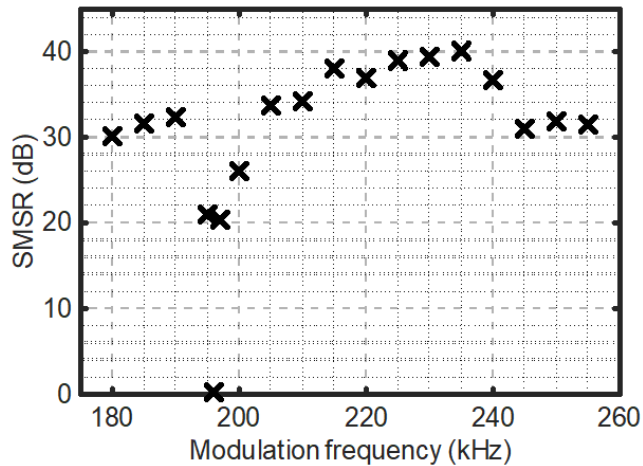
Figure 5. SMSR as a function of various RF modulation frequencies.